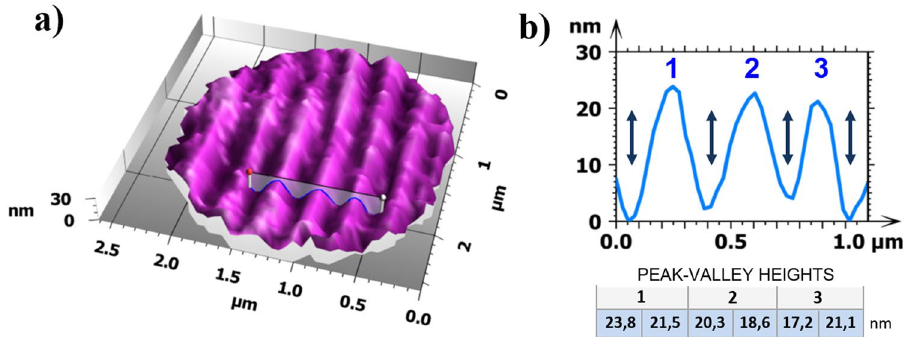
Figure 6. Blu-ray Disc: ( a ) 3D image measured by microsphere assisted interferometry. ( b ) Cross sectional profile from position indicated in ( a ), showing resolved grooves 17.2–23.8 nm